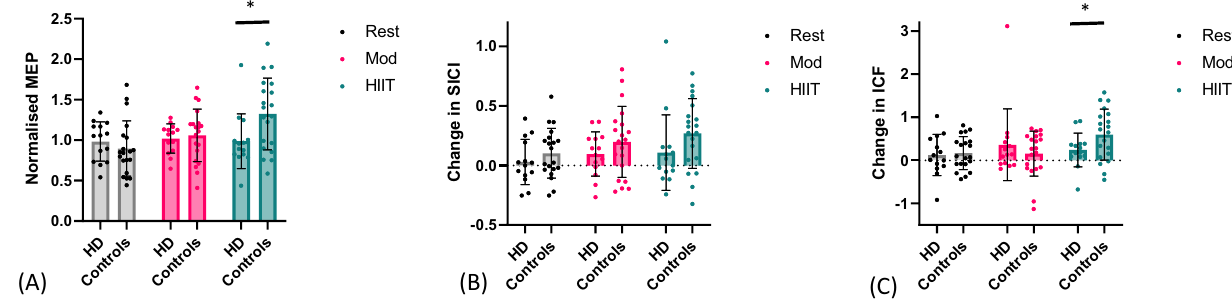
Figure 2. Effect of high-intensity interval training (HIIT), moderate-intensity continuous training (MICT) and rest on TMS measures for each group. Data represent the mean (standard deviation), with individual participant values also shown. ITBS intermittent theta burst stimulation. ( A ) Cortico-motor excitability (CME), average post-iTBS MEP, normalised from post-exercise time-point. ( B ) Short-interval intracortical inhibition (SICI). Change from pre-exercise baseline to average post-iTBS time-points. ( C ) Intracortical facilitation (ICF). Change from pre-exercise baseline to average post-iTBS time-points. * p <